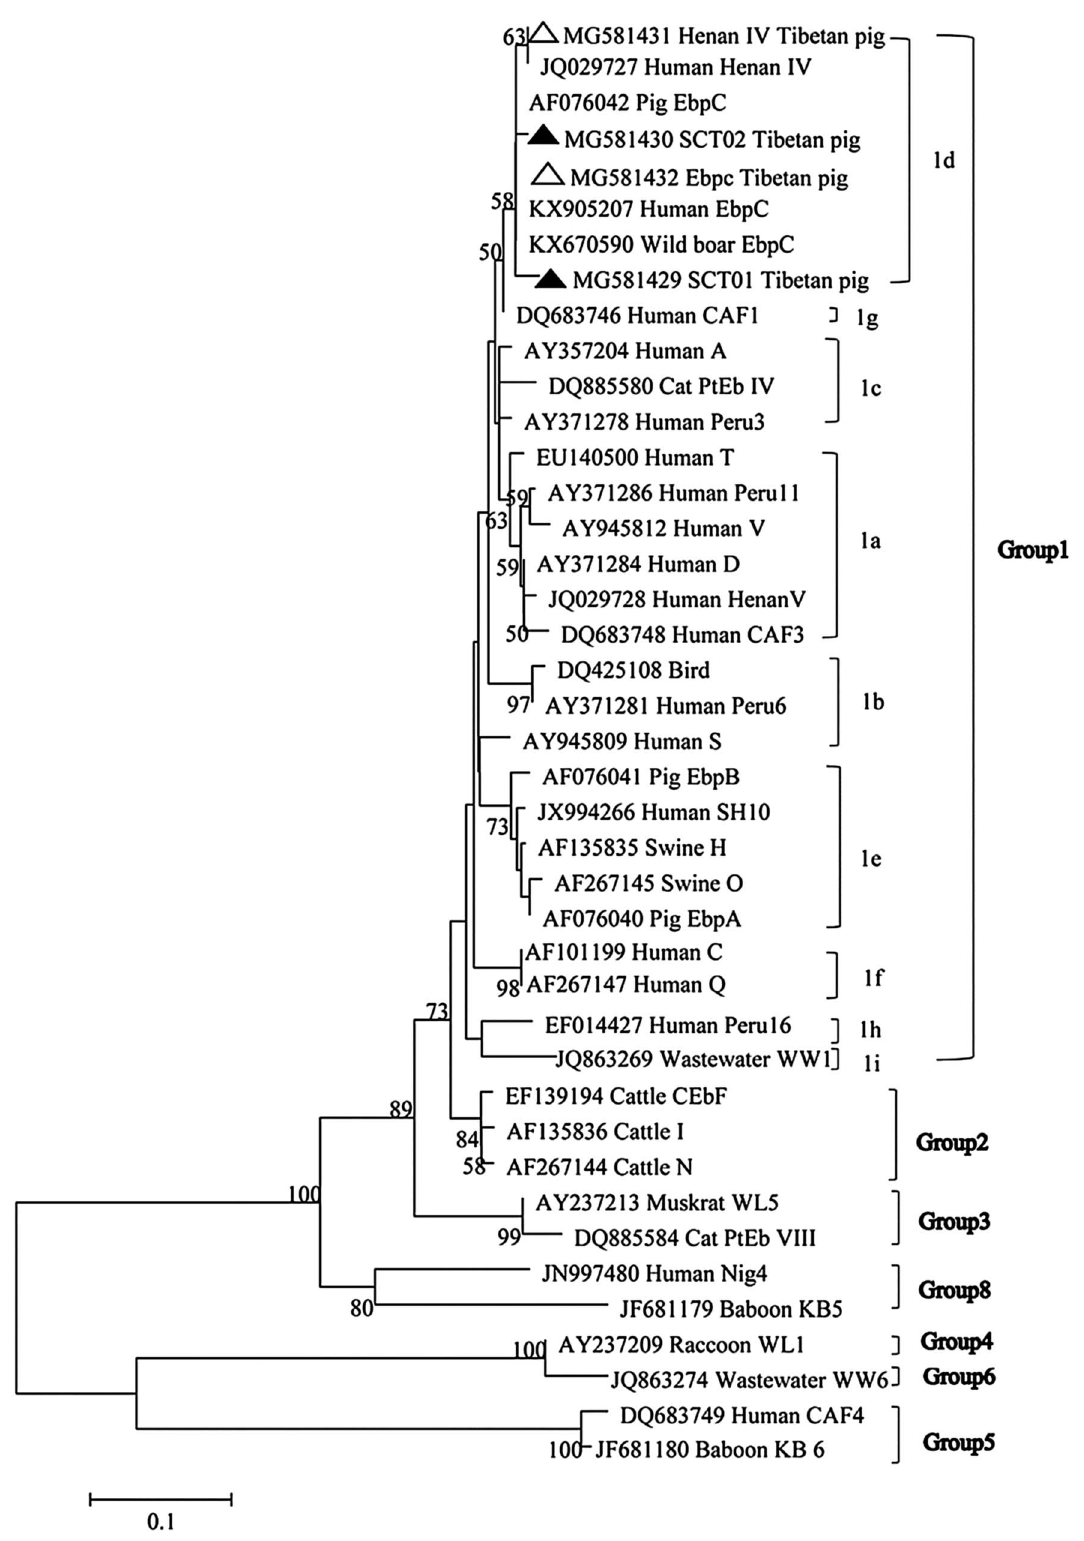
Figure 1. Phylogenetic relationship of Enterocytozoon bieneusi groups. The relationships between E. bieneusi genotypes identi fi ed in this study and other known genotypes deposited in the GenBank were inferred by a neighbor-joining analysis of ITS sequences based on genetic distance by the Kimura-2-parameter model. The numbers on the branches represent percent bootstrapping values from 1000 replicates (only bootstrap values >50% are shown). Each sequence is identi fi ed by its accession number, genotype designation, and host origin. Genotypes with black triangles and open triangle are novel and known genotypes identi fi ed in this study,